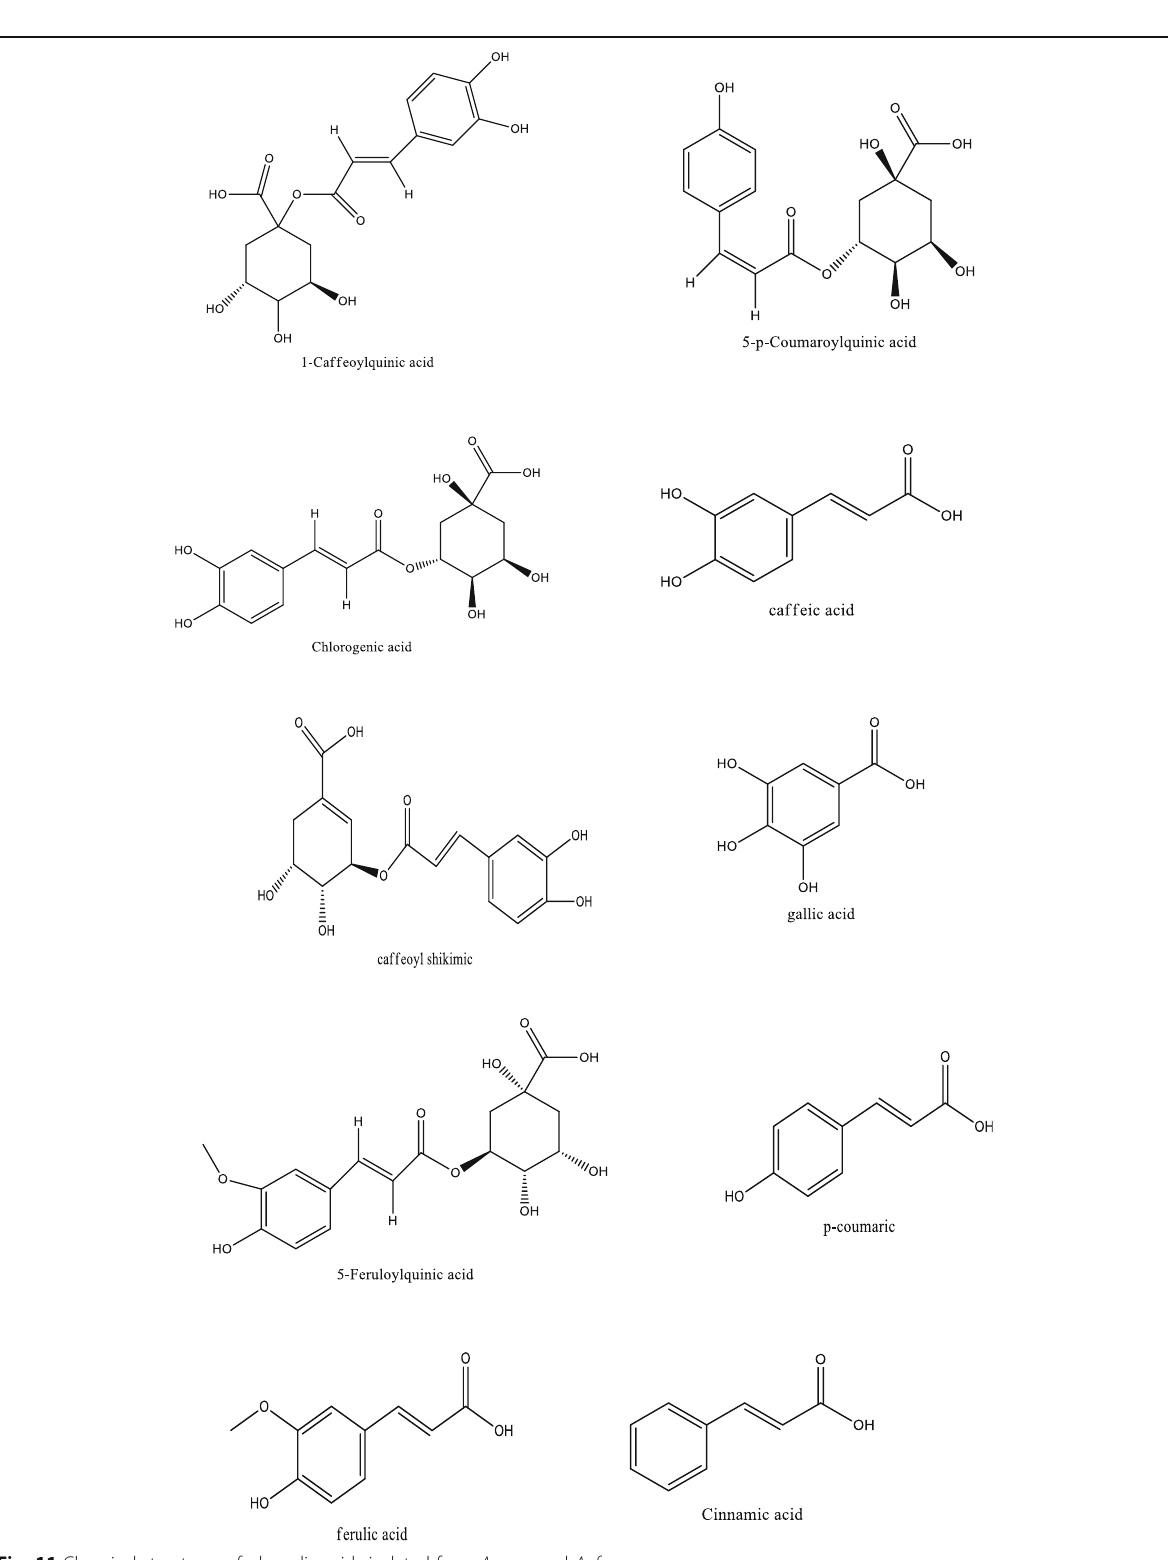
Fig. 11 Chemical structures of phenolic acids isolated from A. vera and A.